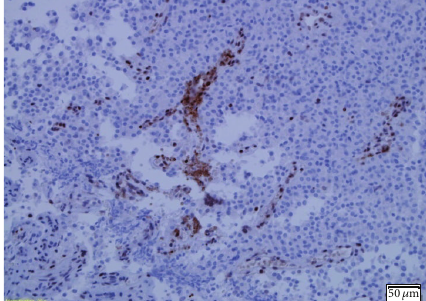
Figure 1: Nuclear staining for Ki-67 antigen (clone MIB1, Dako): MIB-1 proliferative index is greater than 5%.